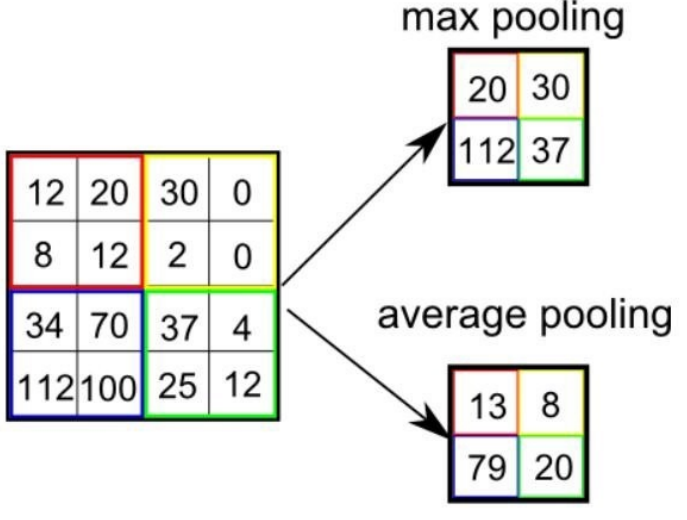
Figure 5. Comparison of max and average